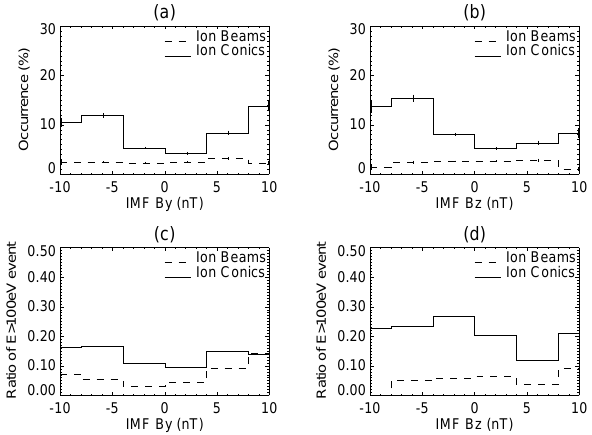
Fig. 1. Occurrence frequency of ion beams and conics as a function of (a) IMF B y and (b) IMF B z and ratio of the energetic ( > 100eV) event to the total event number as a function of (c) IMF B y and (d) IMF B z . The occurrence frequency is integrated over the entire altitude ( < 10000km), invariant latitude (65 ◦ –85 ◦ ), and MLT (9– 15h) ranges. The vertical bar in Figs. 1a and 1b is the statistical